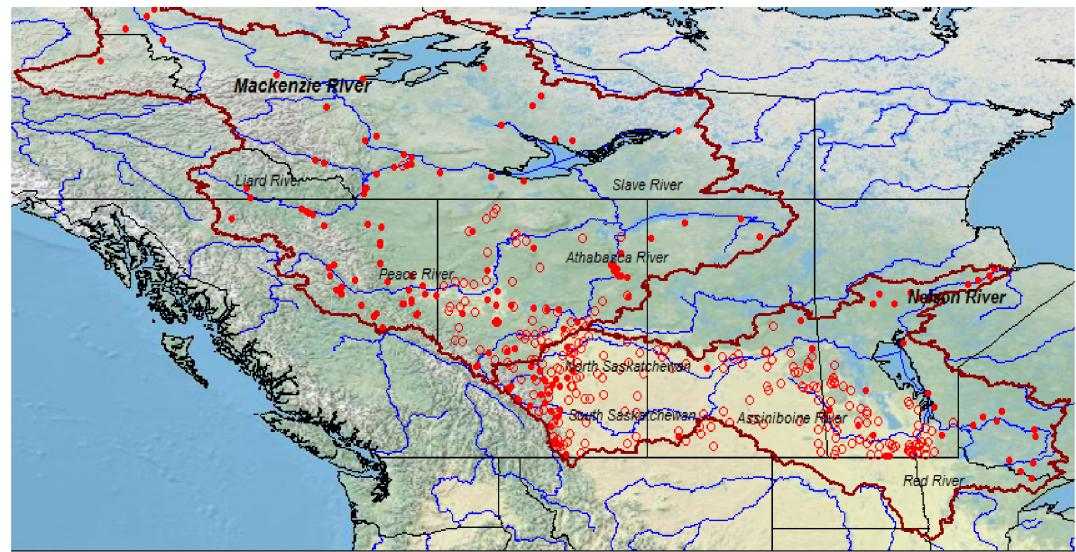
Figure 1. Study area showing the Mackenzie and Nelson River basins (dark-red outline) and the location of continuous stations (red dots) and seasonal stations (red circles). Basemap © OpenStreetMap contributors 2021. Distributed under a Creative Commons BY-SA License. Table 1. Hydrometric stations included in the analysis. Only stations that are in these three basins were considered; to be included, they needed to be designated as having natural streamflow, being active, and having more than 30 years of record. The three other hydrometric stations were associated with a Changing Cold Regions Network Water, Ecosystem, Cryosphere, and Climate (WECC) Observatory with the number of years of record shown in